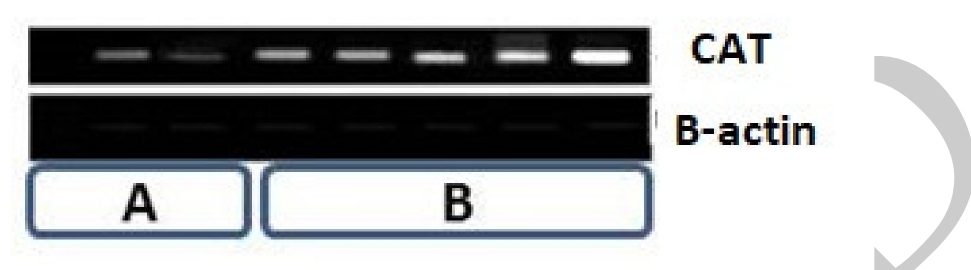
Figure 12. Gene expression of mCAT and m β -actin in the dermal tissues of the diabetic control group and the group treated with the C. molle extract: ( A ) diabetic control group with a deep each wound and ( B ) diabetic group with a deep wound each and treatment with C. molle .